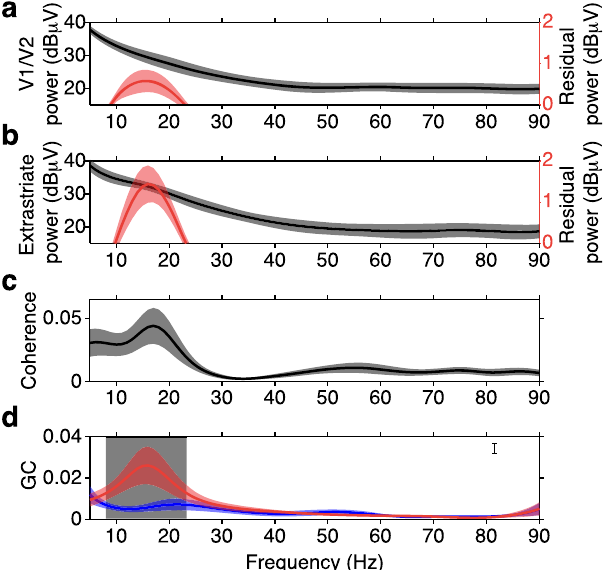
Figure 2. Prestimulus Beta-Frequency Power, Coherence, and sGC Spectra of V1/V2 and V4/TEO LFPs. ( a ) Average striate power spectrum over sites (black line ± s.e.m.), and the residual power spectrum after 1/f removal (red line ± s.e.m.) for V1 sites. ( b ) Average extrastriate power spectrum over sites and monkeys (black line ± s.e.m.), and the residual power spectrum after 1/f removal (red line ± s.e.m.) for the V4/TEO sites. ( c ) Average coherence spectrum over V1/V2-extrastriate site pairs ± s.e.m. for V1/V2-extrastriate pairs. ( d ) Average top-down (red line ± s.e.m.), and bottom-up (blue line ± s.e.m.) GC spectra for V1-extrastriate pairs. Shaded grey rectangular region denotes the frequencies (8–23 Hz) where top-down and bottom-up sGC were significantly different (p <